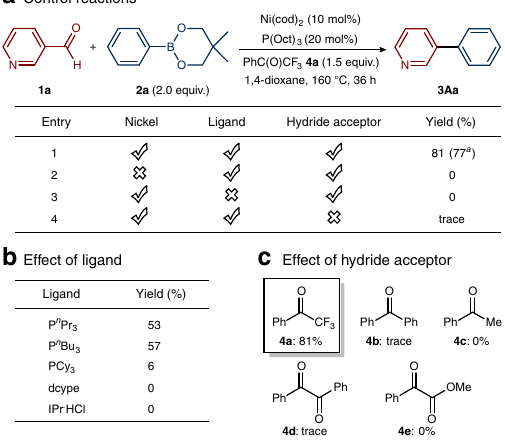
Fig. 2 Optimization of the conditions for the Ni-catalyzed deformylative Suzuki – Miyaura cross coupling and a scaled-up reaction. a Optimal conditions and results of the control reactions. b Effect of the supporting ligand. c , Effect of the hydride acceptor. Yields were determined by gas chromatography ( a , b , and c ). Cod 1,5-cyclooctadiene, Oct octyl, Pr propyl, Bu butyl, Ph phenyl, Me methyl, dcype 1,2-bis(dicyclohexylphosphino) ethane, IPr (cid:129) HCl 1,3-bis(2,6-diisopropylphenyl)imidazolium chloride.